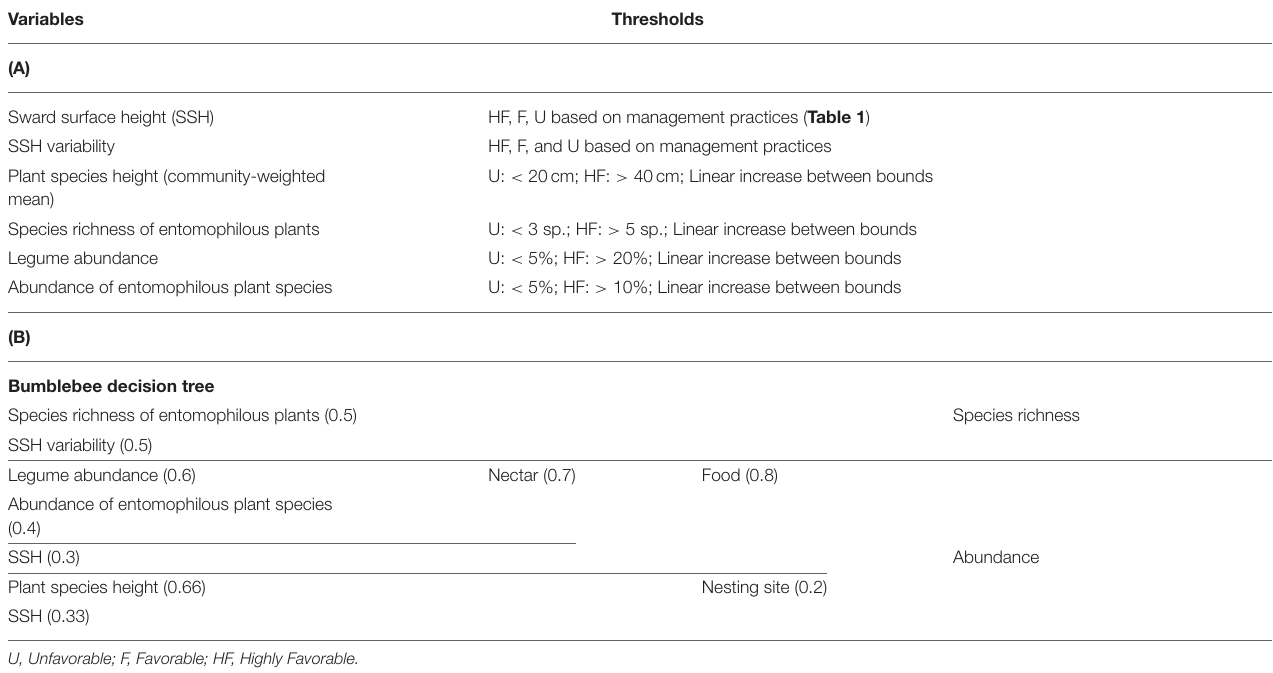
TABLE 4 | (A) Predictive variables, threshold levels and (B) final decision tree of bumblebee abundance and species richness. Variables